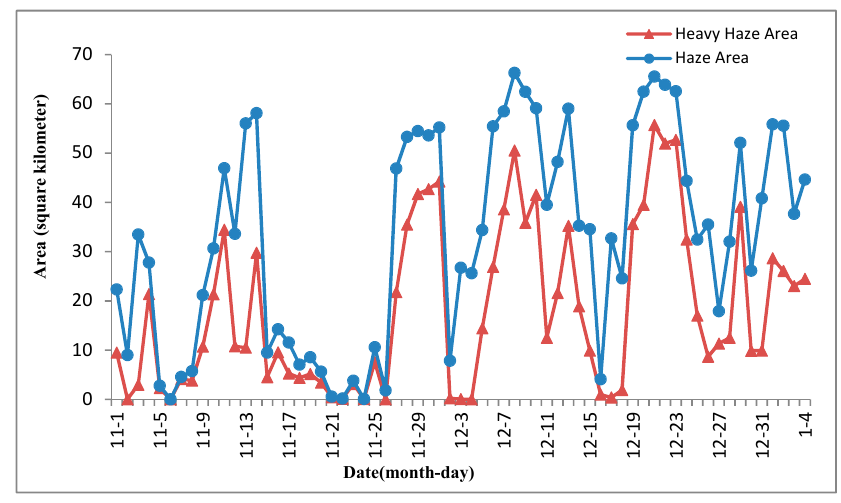
Figure 4. Area and process of haze from 1 November 2015 to 4 January 2016.